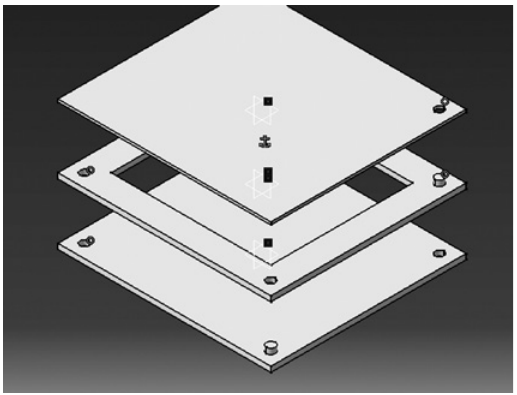
Figure 2 Image of the design of mold cavity used in fabrication.